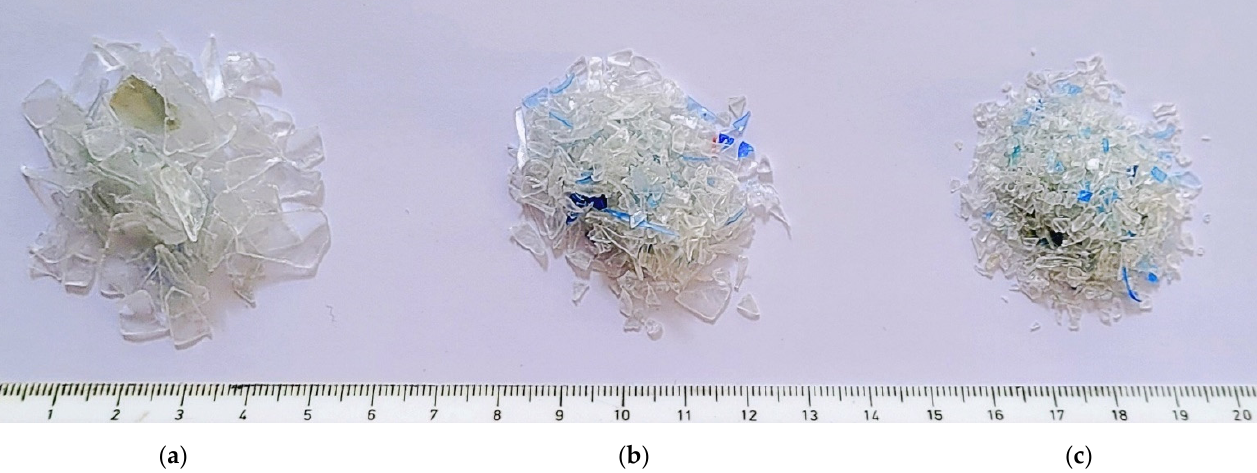
Figure 3. Washed PET fines sorted into fractions: ( a ) above 4.0 mm, ( b ) 2.0 to 4.0 mm, and ( c ) below 2.0 mm.